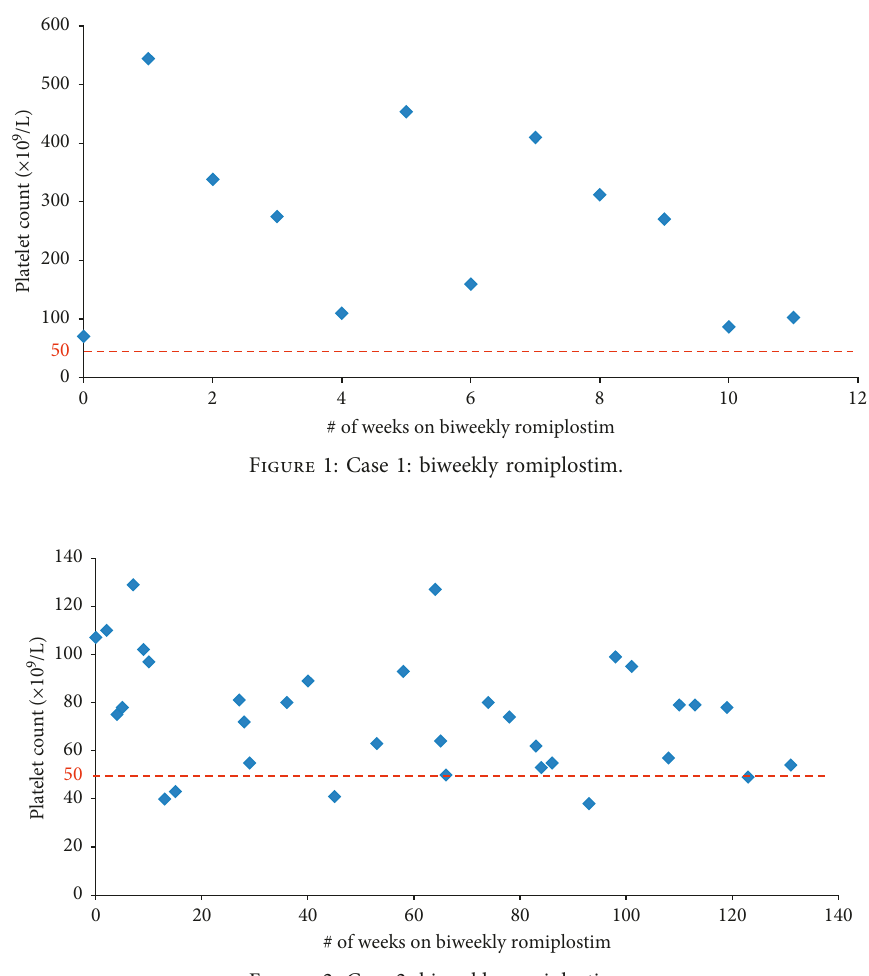
Figure 2: Case 2: biweekly